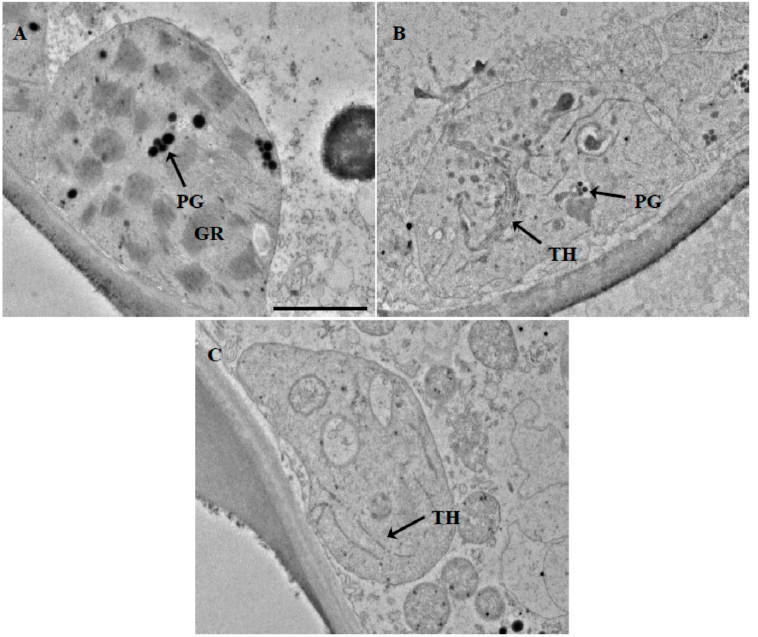
Figure 2. Ultrastructure of mesophyll cells from green ( A ) and yellow ( C ) sectors of variegated leaf, and the full-yellow juvenile leaf ( B ). GR: grana; TH: thylakoid; PG: plastoglobule. Scale bar = 2 μ m. 2.2. Pigment Content in Yellow and Variegated Leaves Pigment contents in yellow and variegated leaves were quantified spectrophotometrically (Table 1). The content of chlorophyll a, chlorophyll b, total chlorophyll (chlorophyll a+b) and carotenoid in the green part of variegated leaves was significantly higher than those of yellow leaves and the yellow part of variegated leaves. Compared with the green part of variegated leaves, the content of total chlorophyll in yellow leaves and the yellow part of variegated leaves were dramatically decreased by 87.35% and 91.57%, respectively. The chlorophyll a/b ratio and total chlorophyll/carotenoid were also significantly high in the green parts. However, no significant differences in the content of chlorophyll a, total chlorophyll and carotenoid between yellow leaves and the yellow part of variegated leaves was found. In addition, the level of anthocyanin between the green and yellow parts was significantly different, whereas the difference between yellow parts of the variegated leaves and yellow leaves was not significant.